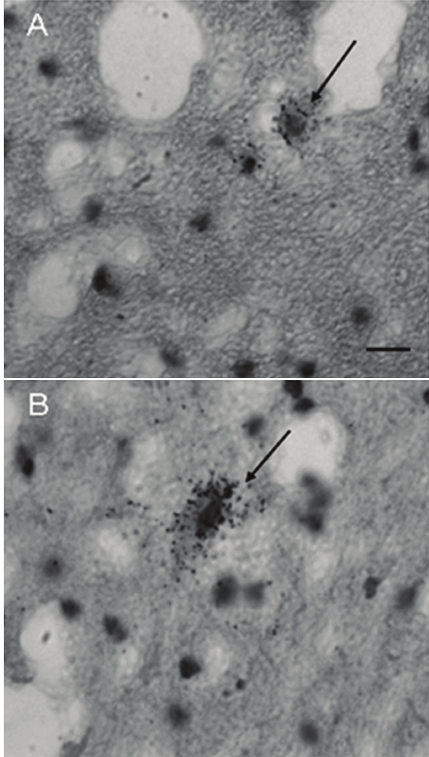
F 5: GAD65 mRNA-labeled neurons (arrows) in the dentate nucleiinacontrolcaseillustratingasmallcellinAandalargercellin